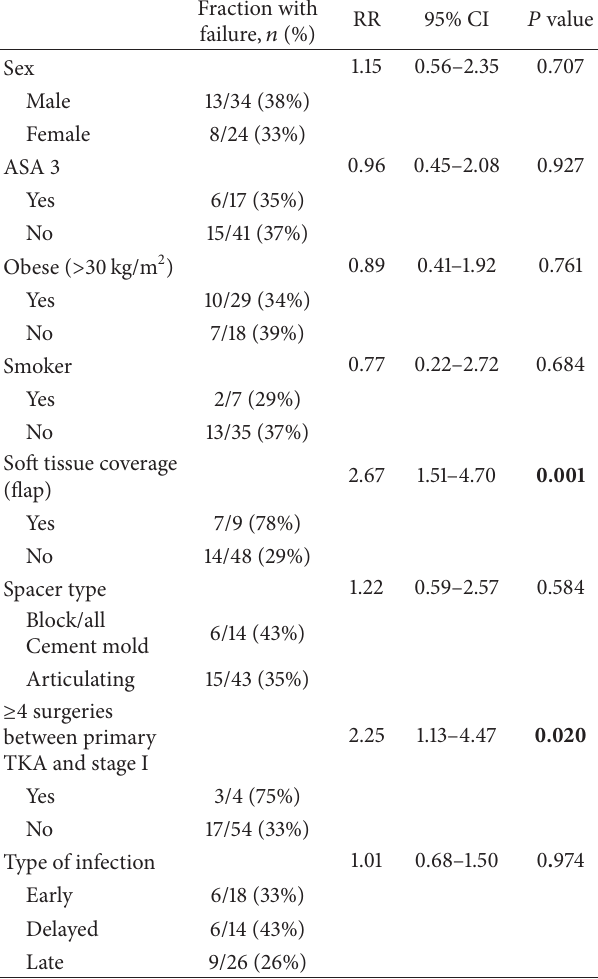
Table 5: Risk factors for failure: patient characteristics and surgical